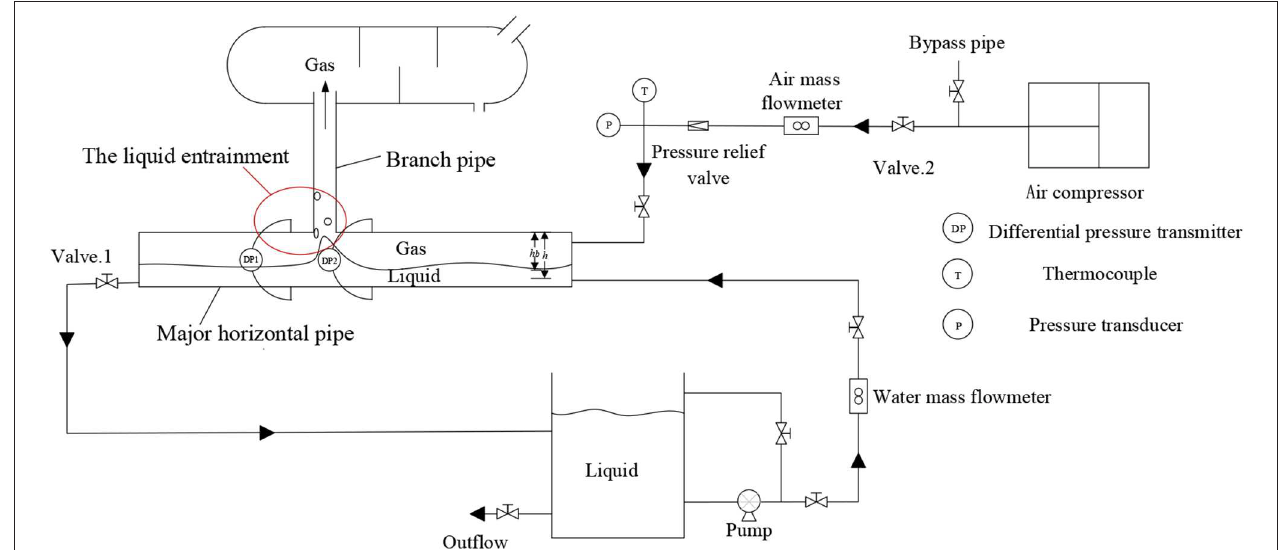
FIGURE 1 | Schematic diagram of the experimental facility and the liquid entrainment of